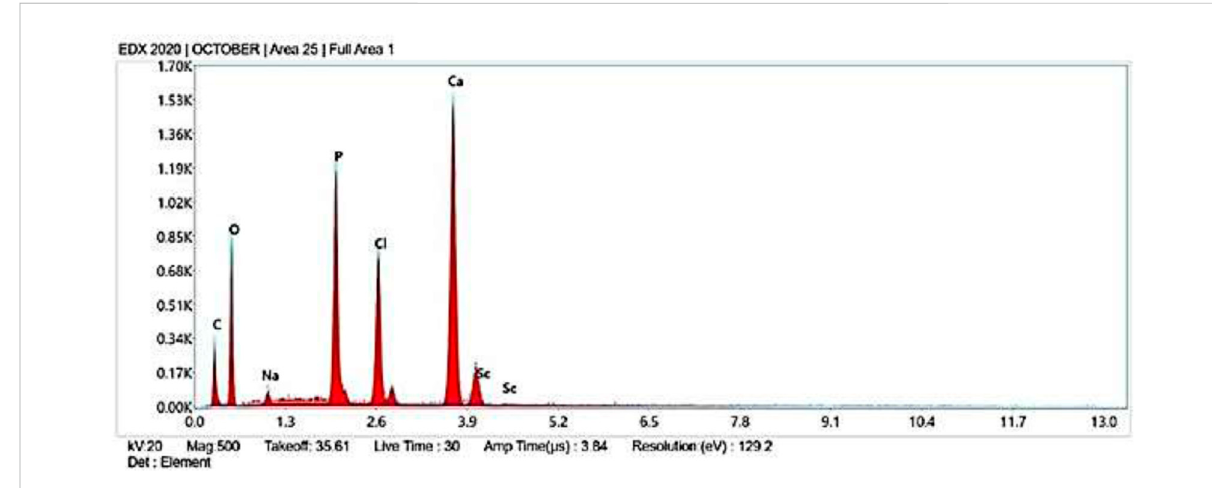
FIGURE 3 EDX images of Areca Catechu L. leaf extract derived hydroxy apatite nanoparticles.